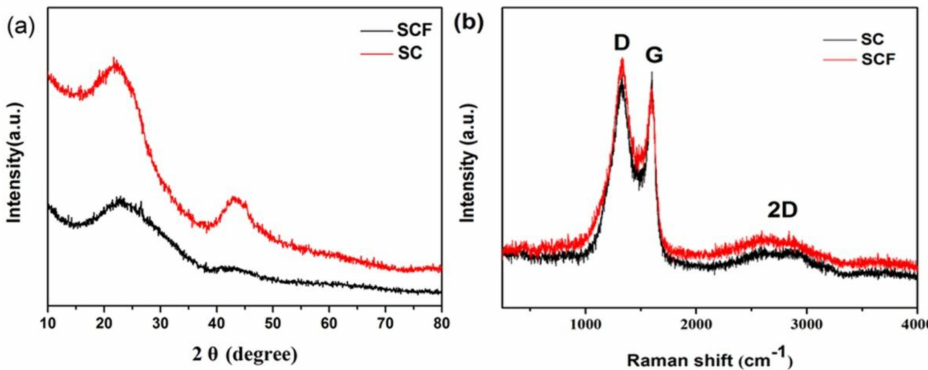
Figure 4. ( a ) X-ray diffraction XRD patterns; ( b ) Raman spectra of SCF and starch-derived carbon